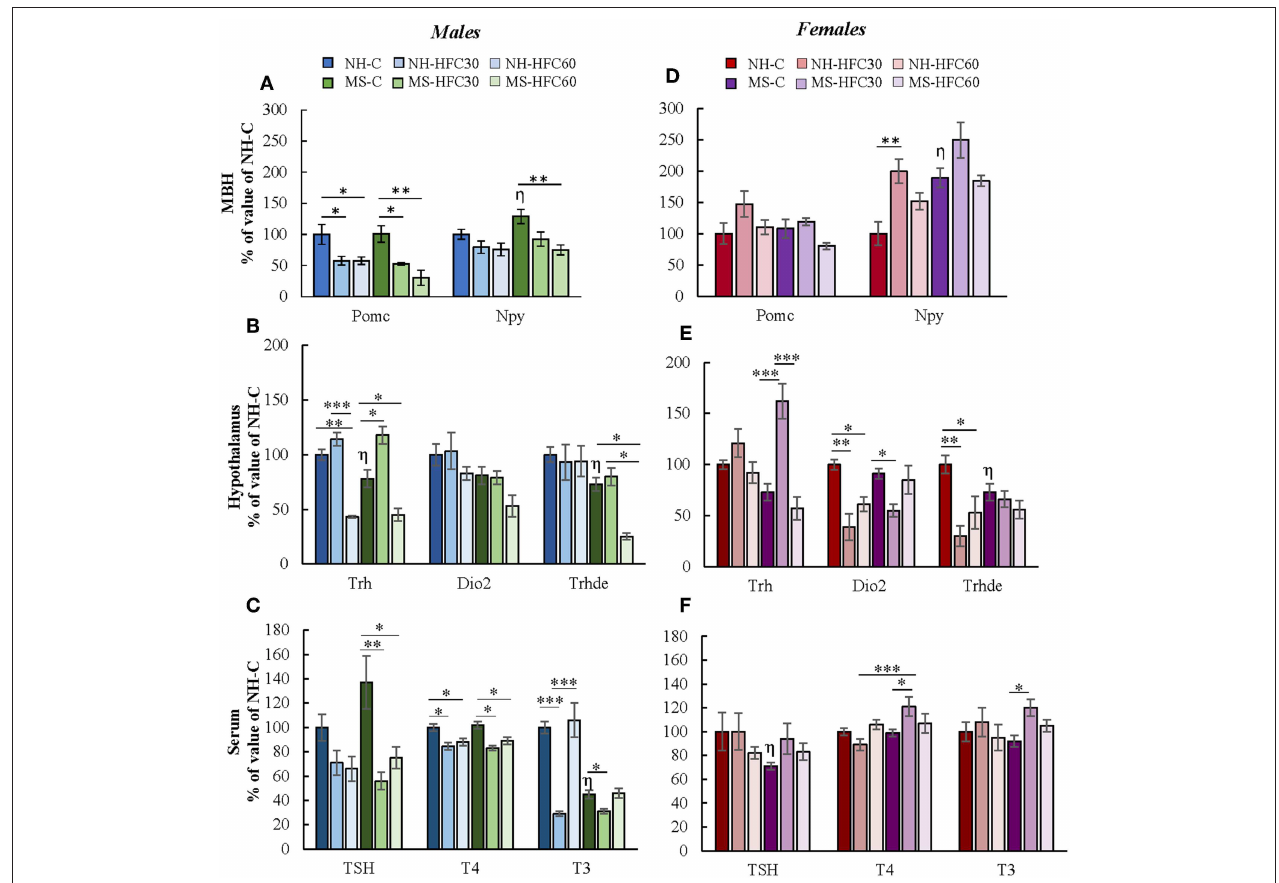
FIGURE 4 | Effect of maternal separation, and a high-fat/high-carbohydrate diet on the expression of arcuate peptides and HPT axis parameters in acutely restrained rats. Non-handled (NH) or maternal separated (MS) male and female rats fed a chow (C) or a high-fat/high-carbohydrate diet (HFC) from Pd30 (HFC30) or 60 (HFC60) until Pd160 were restrained 1h before they were killed. (A,D) Expression levels of pro-opiomelanocortin ( Pomc ) and neuropeptide Y ( Npy ) in the mediobasal hypothalamus (MBH). (B,E) Expression levels of Trh in the paraventricular nucleus and of Dio2 and Trhde in the MBH: (C,F) Serum concentrations of TSH, T4, and